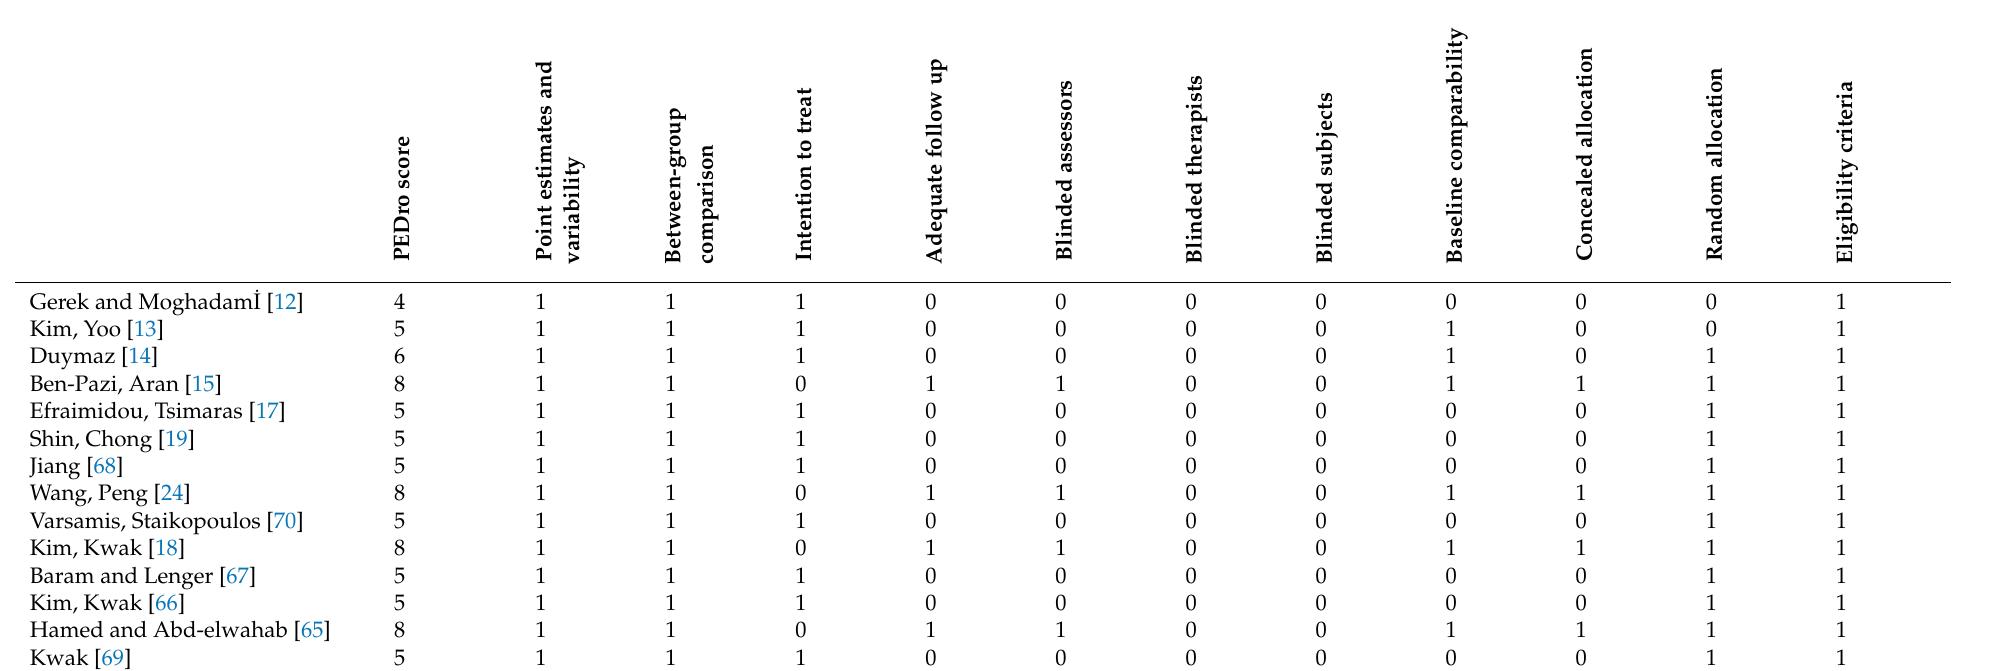
Table 2. Detailed PEDro scoring of the included studies (1: bias absent, 0: bias